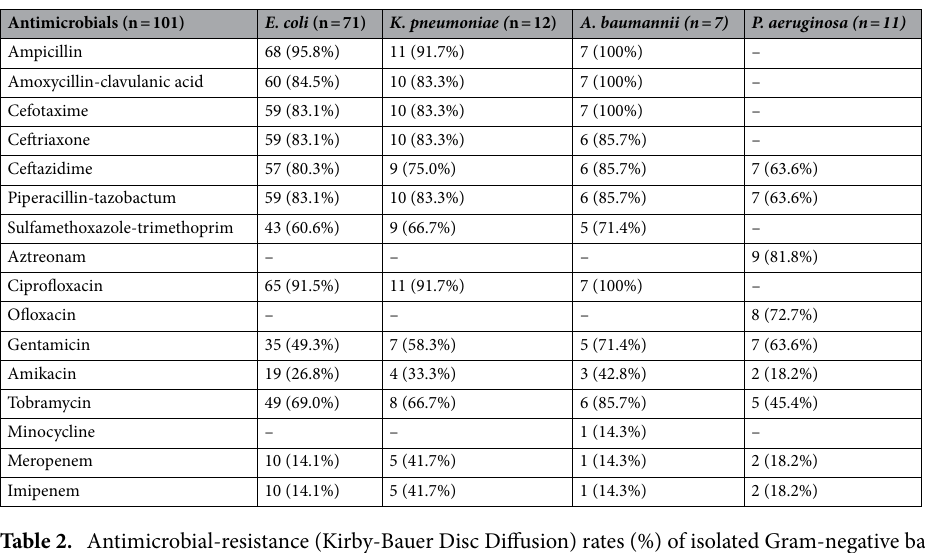
Table 2. Antimicrobial-resistance (Kirby-Bauer Disc Diffusion) rates (%) of isolated Gram-negative bacteria.